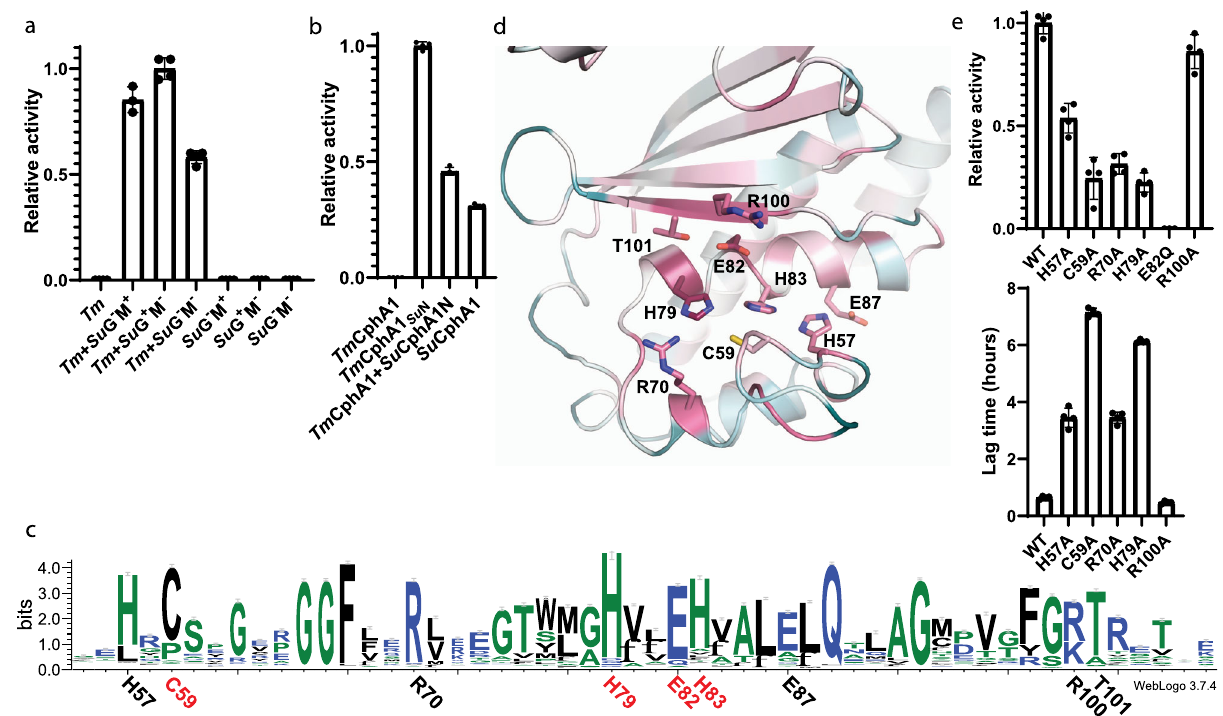
Fig. 2 The N domain of CphA1 is responsible for primer-independent activity. a Primer-independent activity of Tm CphA1 in the presence of Su CphA1 constructs with inactivating mutation as the G and/or M domains 11 . Active G and M domains are not required for activity, suggesting a different part of Su CphA1 is responsible for primer independence. n = 4 independent experiments. Data are presented as individual measurements and mean value, error bars represent SD values. b Su CphA1 N domain confers primer independence. Tm CphA1 is inactive in the absence of primers. A chimera of Tm CphA1 G and M domains and Su CphA1 N domain ( Tm CphA1 Su N ) is active. Reactions including Tm CphA1 and 5 μ M of a construct of the extruded N domain of Su CphA1 harboring solubilizing mutations Y14S and I17T show cyanophycin synthesis in the absence of primers. Note that the extruded Su CphA1 N domain was completely insoluble before introducing mutations into a hydrophobic loop that, in the intact enzyme, interacts with the M domain (Supplementary Fig. 2d). n = 4 independent experiments. Data are presented as individual measurements and mean value, error bars represent SD values. c Weblogo 60 diagram showing the conserved Cx 19 HxxEH motif. This Weblogo was constructed from sequence alignments of all CphA1 enzymes generated by ClustalOmega 61 , and excludes cyanophycin synthetase 2 (CphA2) sequences. CphA2s are specialized cyanobacterial enzymes that polymerize β -Asp-Arg dipeptides recovered from degraded cyanophycin 27,62 . CphA2 N domains share a low sequence identity with CphA1 N domains and the N domain active site motif is absent from CphA2 sequences. d The N domain of Su CphA1 colored by per-residue conservation. The residues around the Cx 19 HxxEH motif are conserved (purple). The conservation was calculated by Consurf 63 using 500 randomly chosen CphA1 sequences. e Activity rate and lag time (time until V max is reached) of Su CphA1 N domain mutants without added primer. All mutants except R100A displayed varying levels of reduced activity rate and longer lag phases than the WT enzyme. E82Q was inactive and its lag time is not shown. n = 4 independent experiments. Data are presented as individual measurements and mean value, error bars represent SD